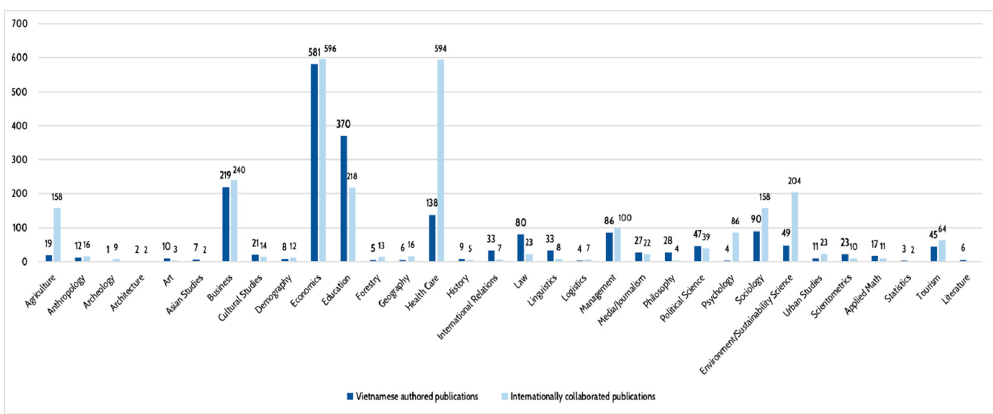
Figure 5. The number of publications domestically collaborated and internationally collaborated by discipline during the period from 2008–2019 (last updated 30 April 2020).